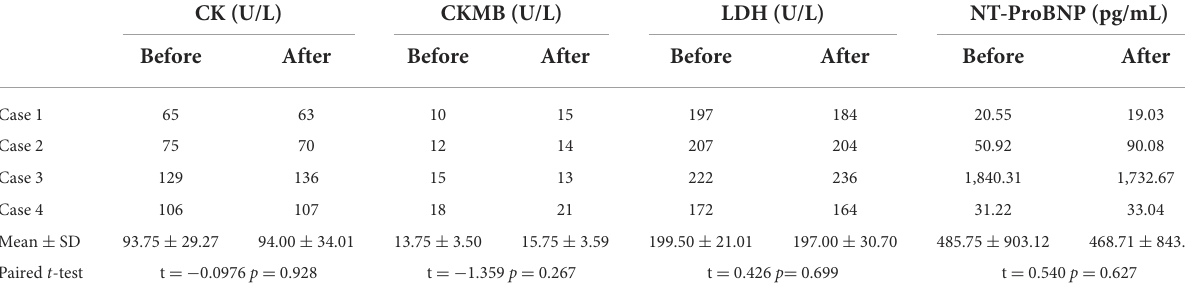
TABLE 2 Changes in myocardial enzymogram and NT-proBNP before and after head down tilt